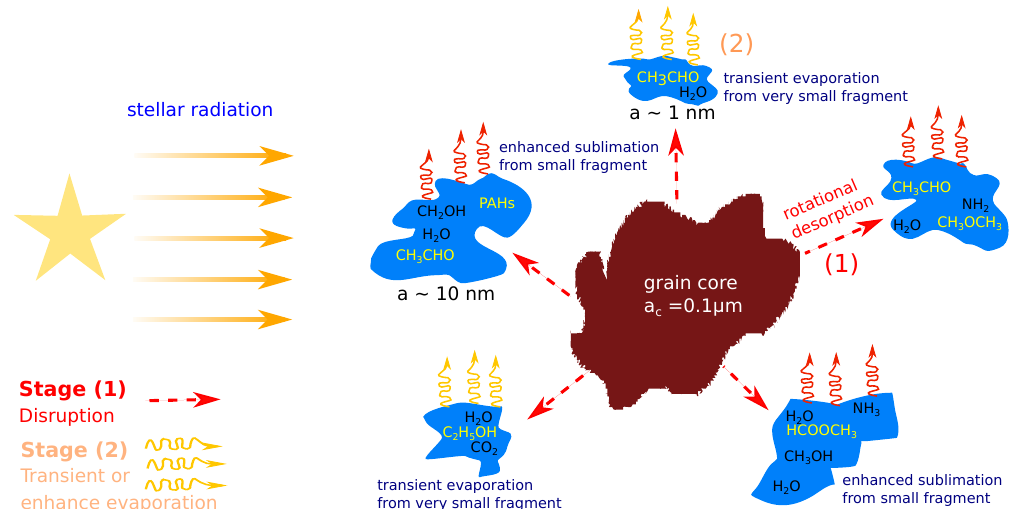
Figure 7. Schematic illustration of the rotational desorption process of complex organic molecules (COMs) from icy grain mantles comprising two steps: (1) disruption of icy mantes into small fragments by Radiative Torque Disruption (RATD), and (2) rapid evaporation of COMs due to thermal spikes for very small fragments or increased sublimation for larger fragments. From Hoang and Tram [44].